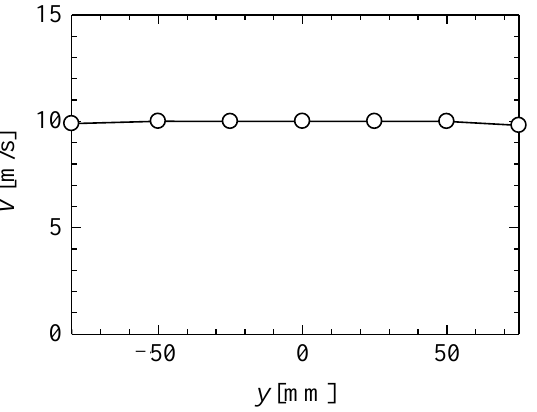
Figure 5. Mean-flow-velocity distribution in the lateral direction at x = 0 without turbines.